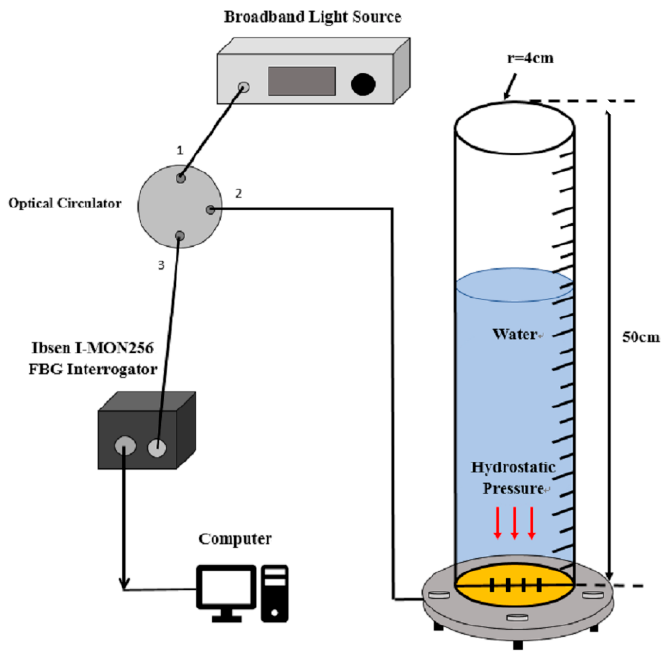
Figure 3. Schematic diagram for the measurements of hydrostatic pressure and liquid level.